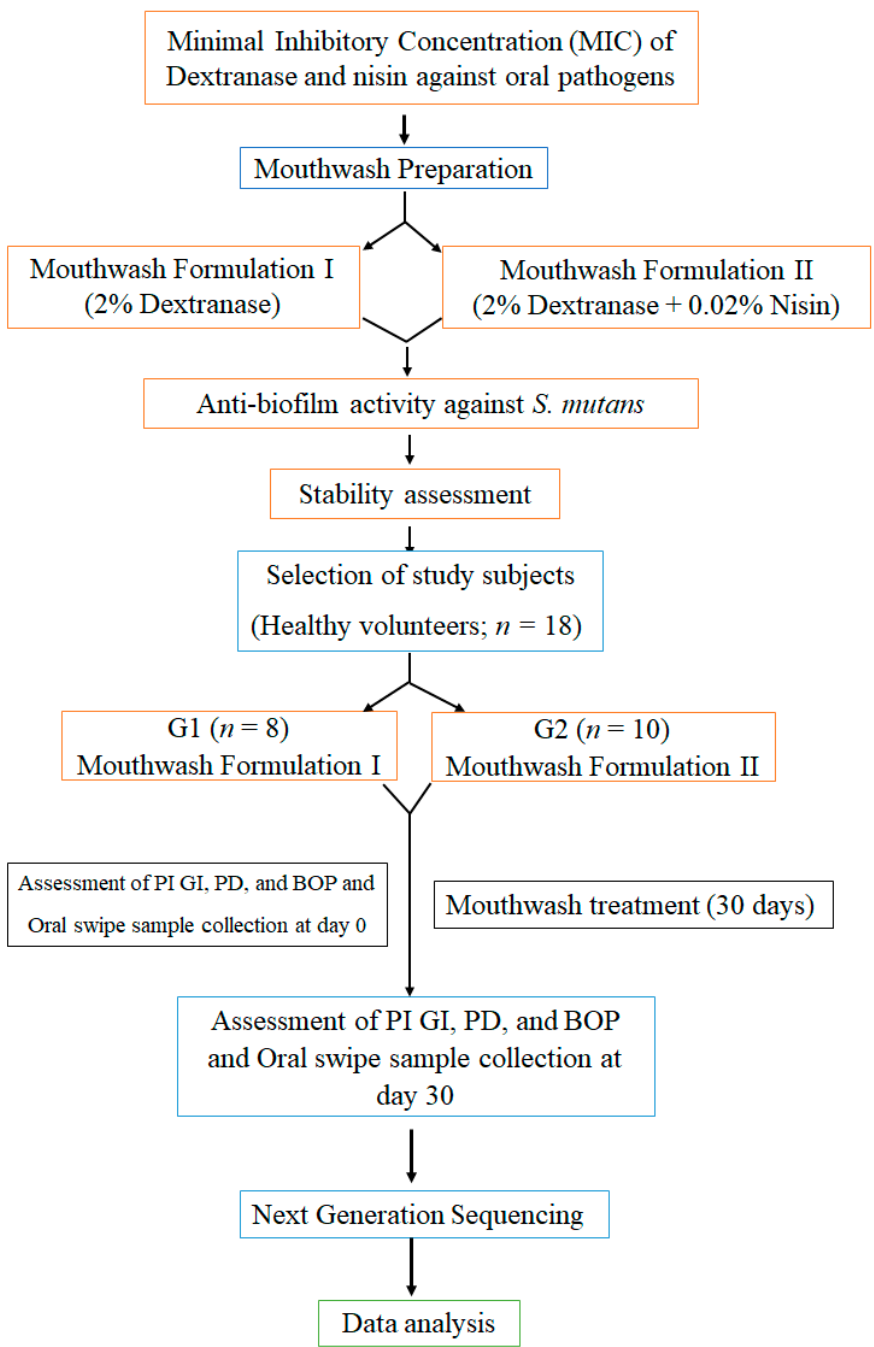
Figure 1. Follow chart describes the experimental procedure of the